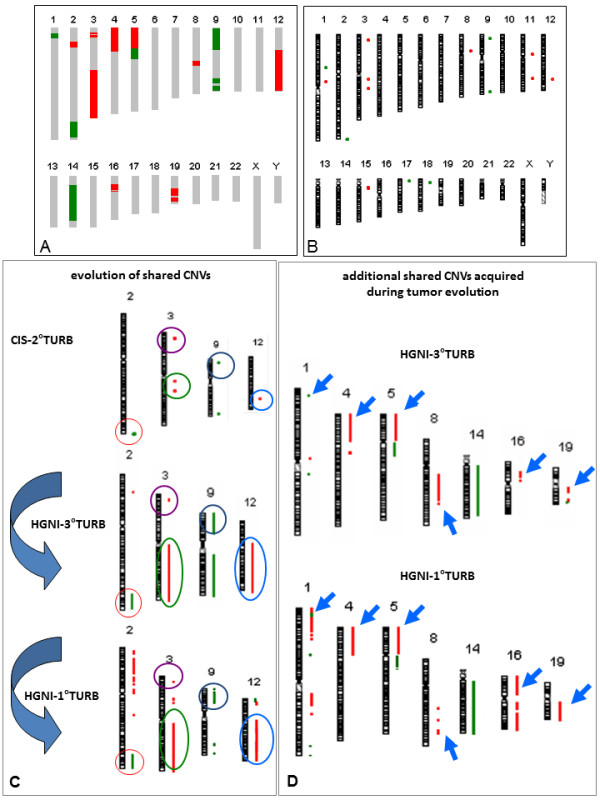
Array-CGH. A: Common CNVs in loss (green) and in gain (red) between the first and the third biopsy. B: Second biopsy. C: Evolution of shared CNVs; each color identifies a specific CNV. D: Additional shared CNVs acquired during tumor evolution; the shared CNVs are indicated by arrows.